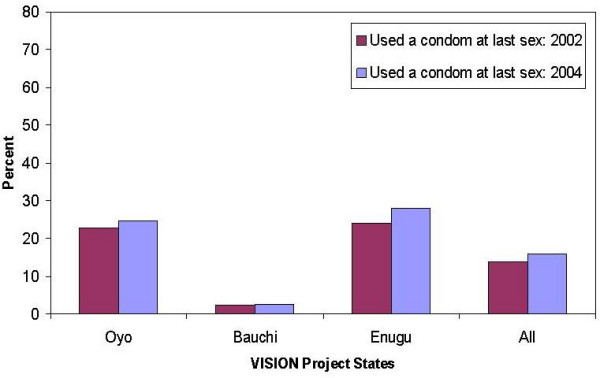
VISION outcome indicator in relation to 2002 baseline data: Condom use at last sex Figure legend text – Percentage of respondents that used a condom at last sex: 2002 baseline and 2004 follow-up data. Aggregated estimates were calculated using weighted data